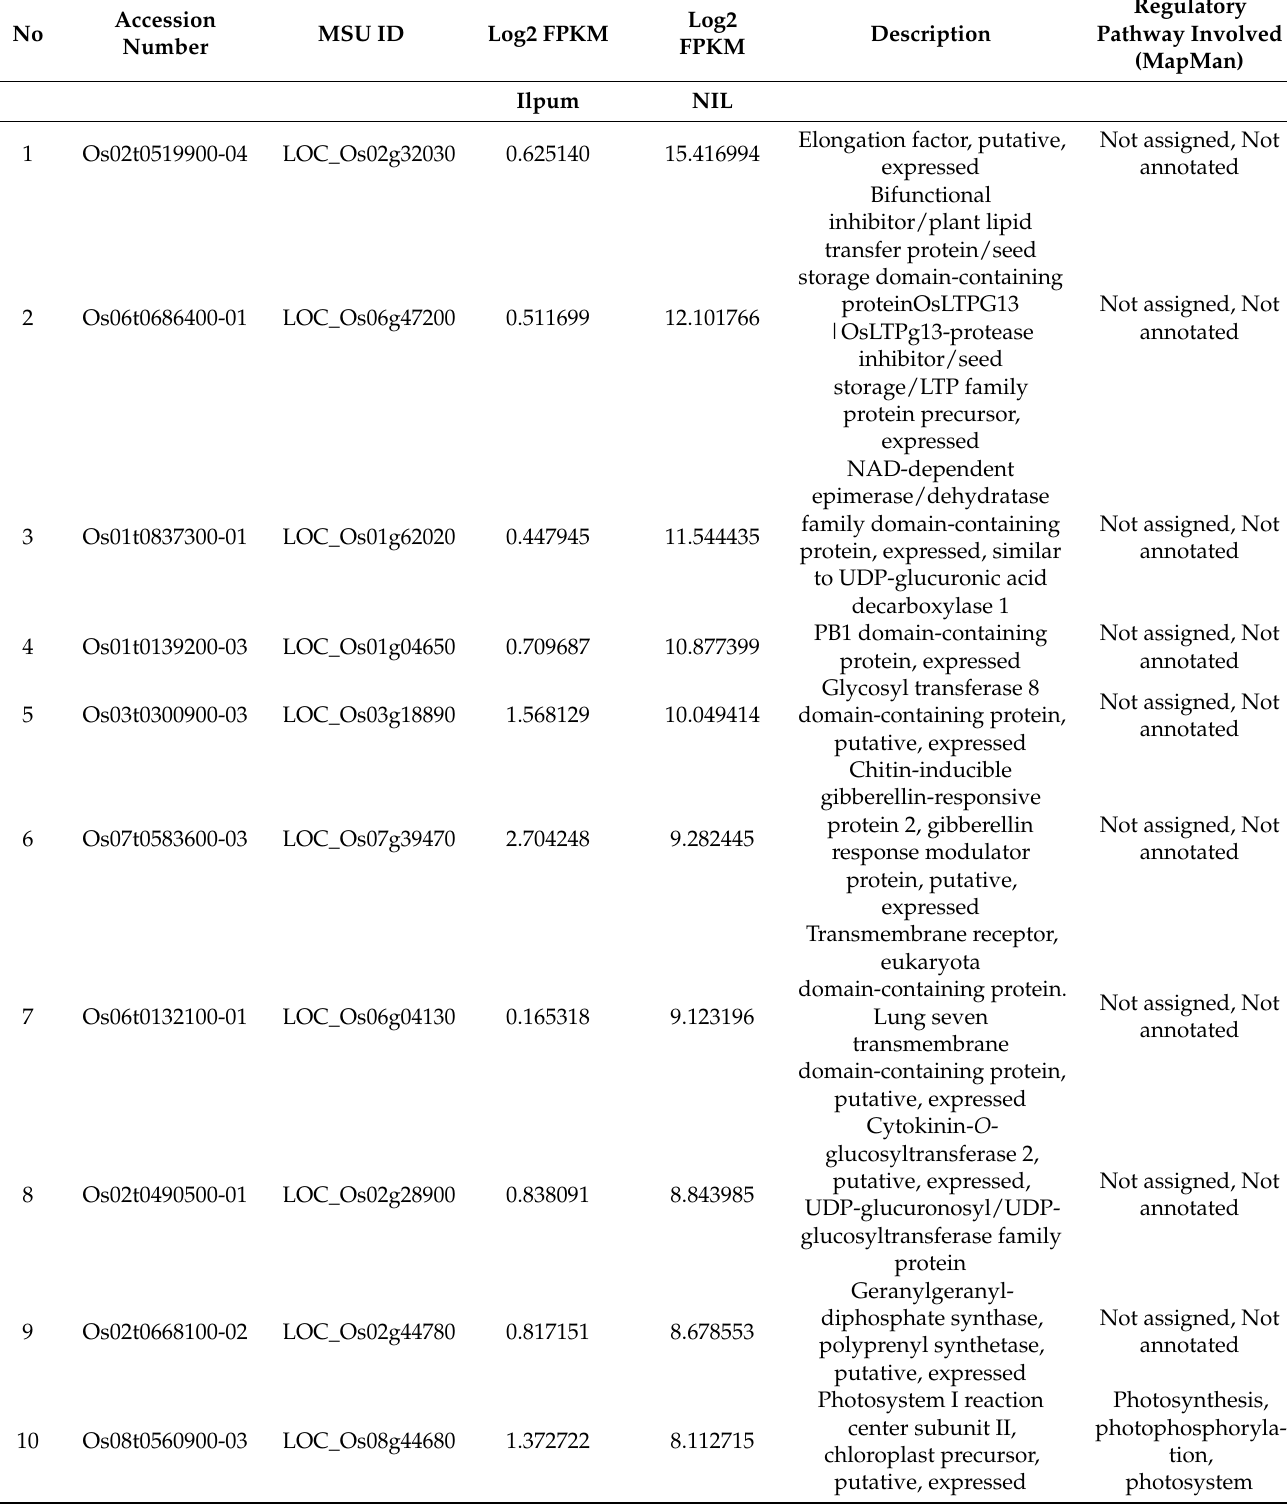
Table 2. Top 10 exponentially induced genes in NIL compared to